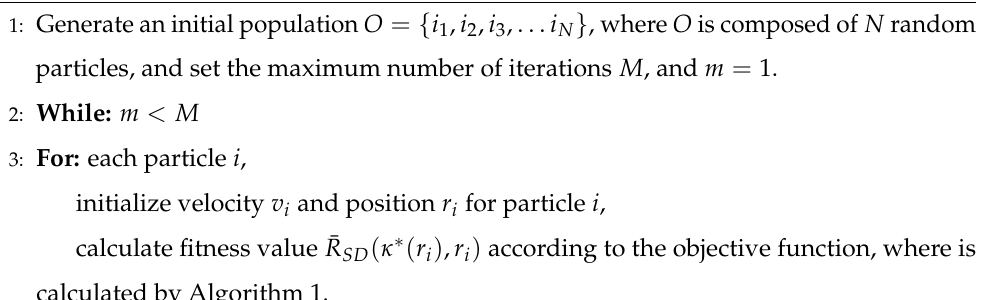
Algorithm 2 Bisection-PSO SE optimization